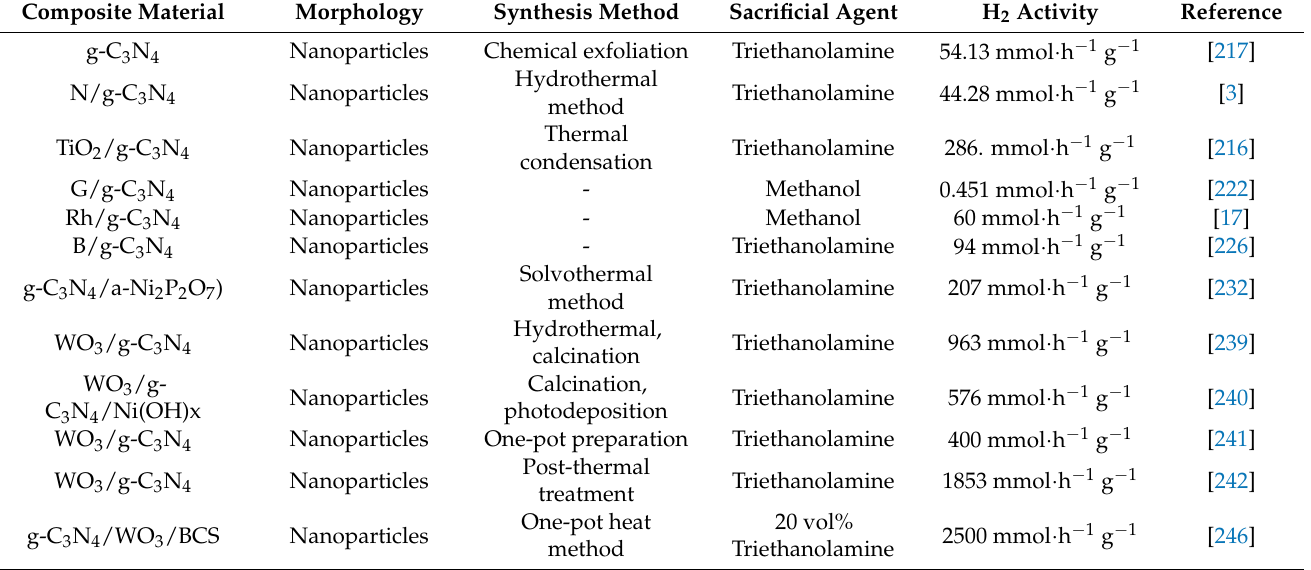
Table 5. H 2 production rate with reported g-C 3 N 4 -based